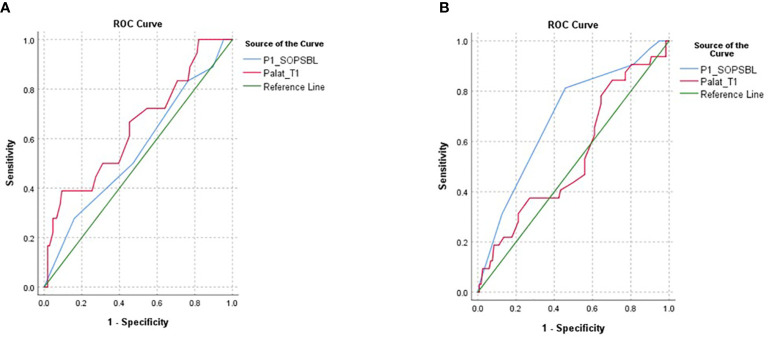
The figure shows AUC for female (A) and male (B) CHR participants since the significant conversion effects on startle latency were present in the females but not males. Startle latency (PA lat_t1) was more predictive of later conversion in females (AUC = 0.65) than males (AUC = 0.54) while P1, a measure of unusual thought content from the SIPS (P1_SOPSBL) was more predictive of later psychosis in males (AUC = 0.69) than in females (AUC = 0.55) but both were short of statistical significance.